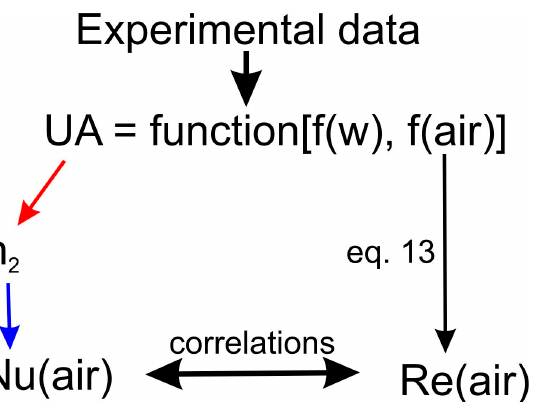
Table 3. Parameters for Nusselt number correlations of tested radiators.